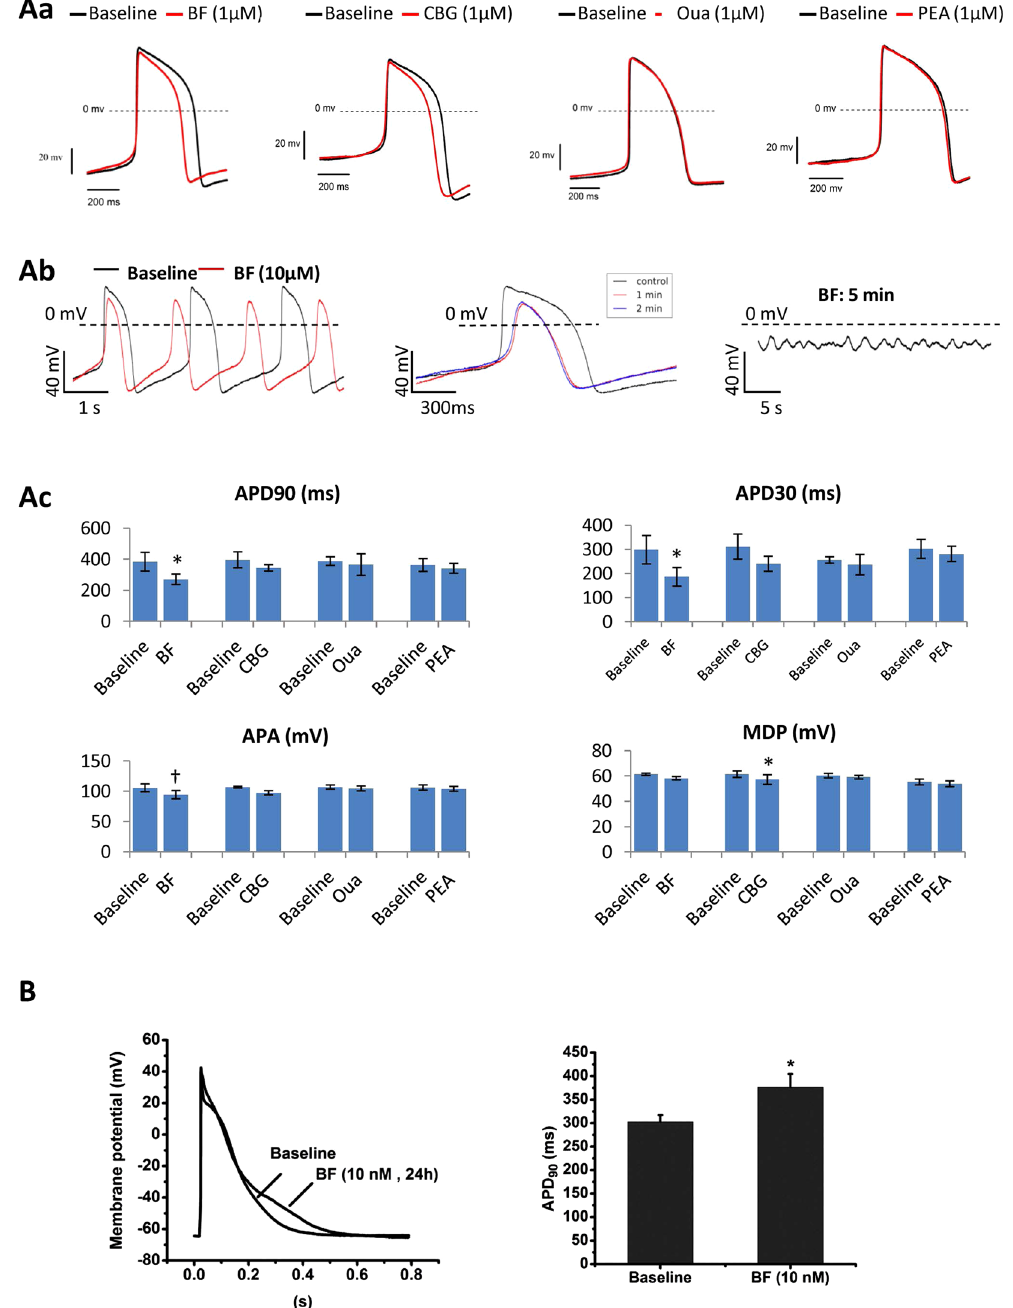
Figure 5. Effect of CGs on APs in hESC-CMs. Effects of CGs on APs were recorded in single hESC-CMs. ( A a) Representative AP waveforms recorded in hESC-CMs exposed to 1 µ M of BF, CBG, Oua and PEA for 1–2 minutes. ( A b) Representative AP waveforms recorded in hESC-CMs treated with BF (10 µ M) for different time points. ( A c) Bar-graphs show APD90, APD30, APA and MDP measured in hESC-CMs 2 minutes post application of BF, CBG, Oua and PEA. * p < 0.05, † p < 0.01, vs. baseline (two-tailed paired Student t-tests). Data are presented as mean ± SEM. ( B ) Representative superimposed AP waveforms recorded in hESC-CMs exposed to 0.1% DMSO (as vehicle control) and BF (10 nM) for 24 hours. n =